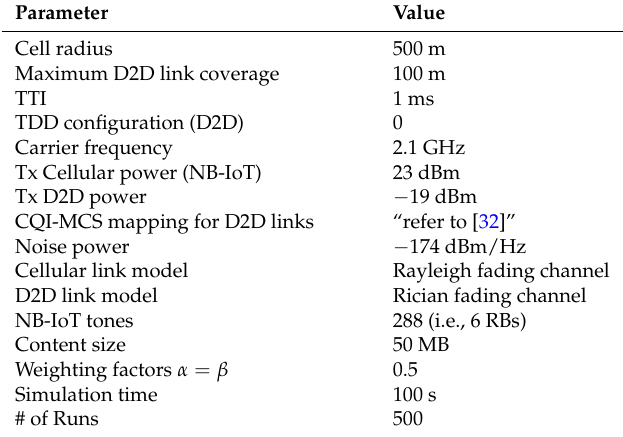
Table 2. Mainsimulationparameters. NB-IoT:narrowbandInternetofthings; CQI:channelqualityindicator; MCS: modulation and coding scheme; TTI: Transmission time interval; TDD: Time division duplex.